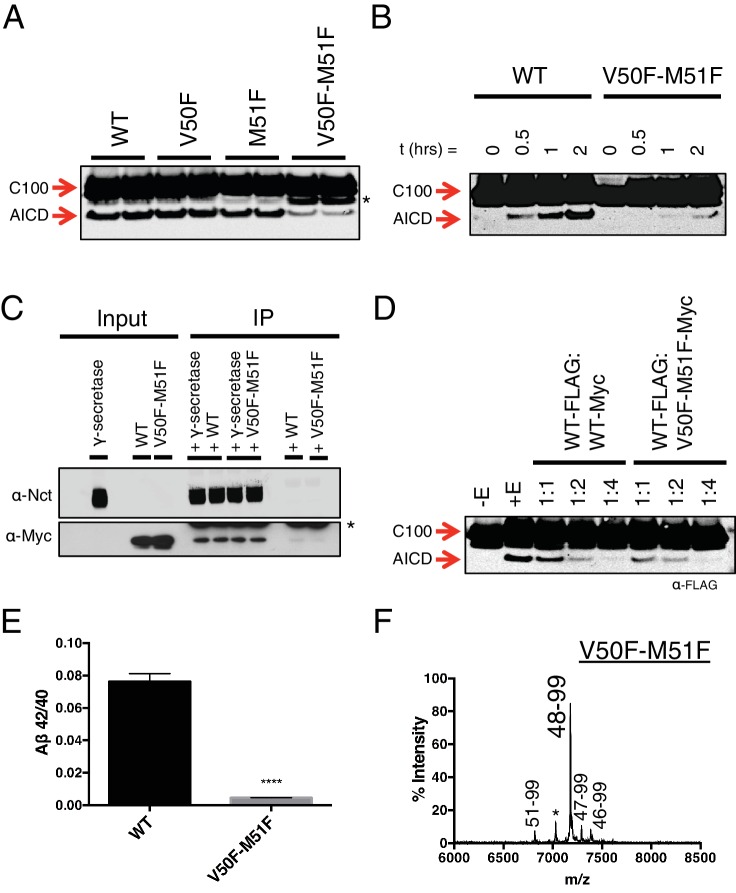
Phenylalanine blocking mutations at both ε cleavage sites reduces APP cleavage but not binding to γ-secretase.(A) Western blot of γ-secretase cleavage of WT, V50F, M51F and V50F-M51F C100-FLAG. Duplicates from each substrate represent separate independent data points. * denotes a degradation product which co-purified with the substrate. (B) Cleavage of WT and V50F-M51F C100-FLAG over time. (C) Co-immunoprecipitation of Myc-tagged WT or V50F-M51F C100 substrate. Duplicates are from separate pull-down experiments. * antibody light chain. (D) Competitive cleavage of WT C100-FLAG by WT C100-Myc or V50F-M51F C100-Myc. (E) Aβ42/40 ratio of the V50F-M51F double mutant. Mean ± SD, n = 3, t-test, ****<0.0001. (F) MALDI/TOF MS of the AICD fragment from the V50F-M51F mutant: (AICD 51–99, expected mass: 6822.5, observed mass: 6817.1; * unknown peak, observed mass: 7030.4; AICD 48–99, expected mass: 7183.9, observed mass: 7179.2; AICD 47–99, expected mass: 7297.1, observed mass: 7292.5, AICD 46–99, expected mass: 7396.2, observed mass: 7396.1).